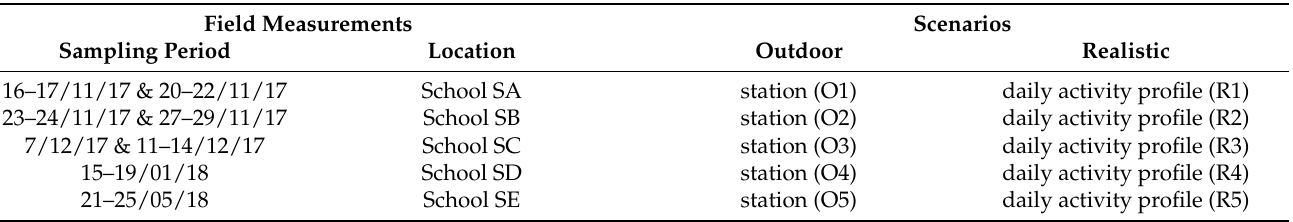
Table 1. Sampling period for each school and respective exposure scenario (realistic/outdoor) for each